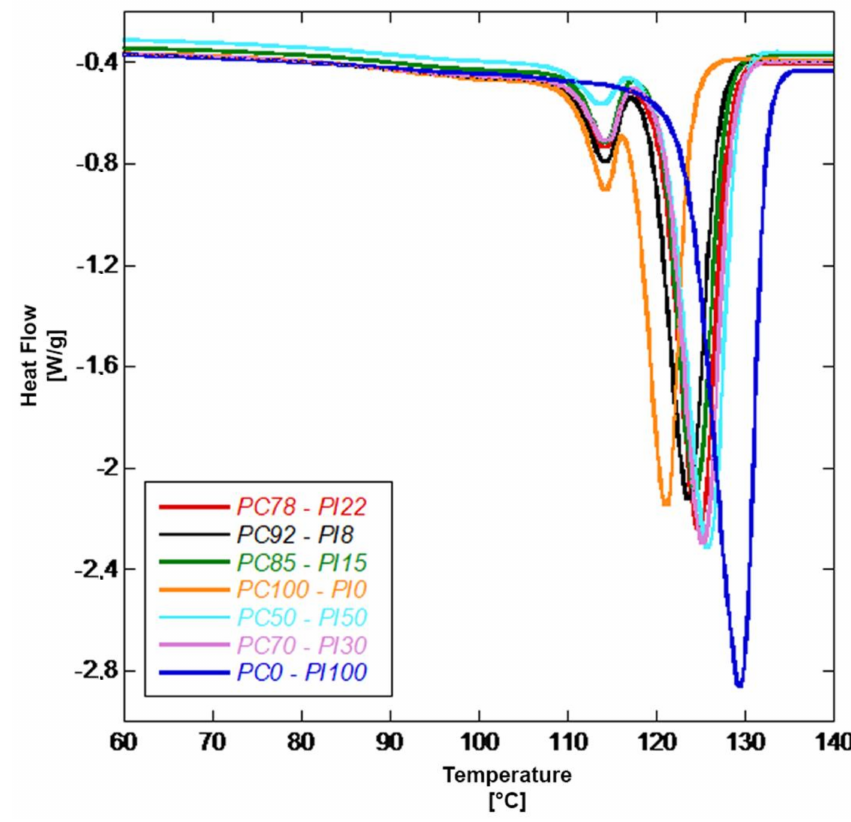
Figure 5. Thermograms of all blends during the cooling